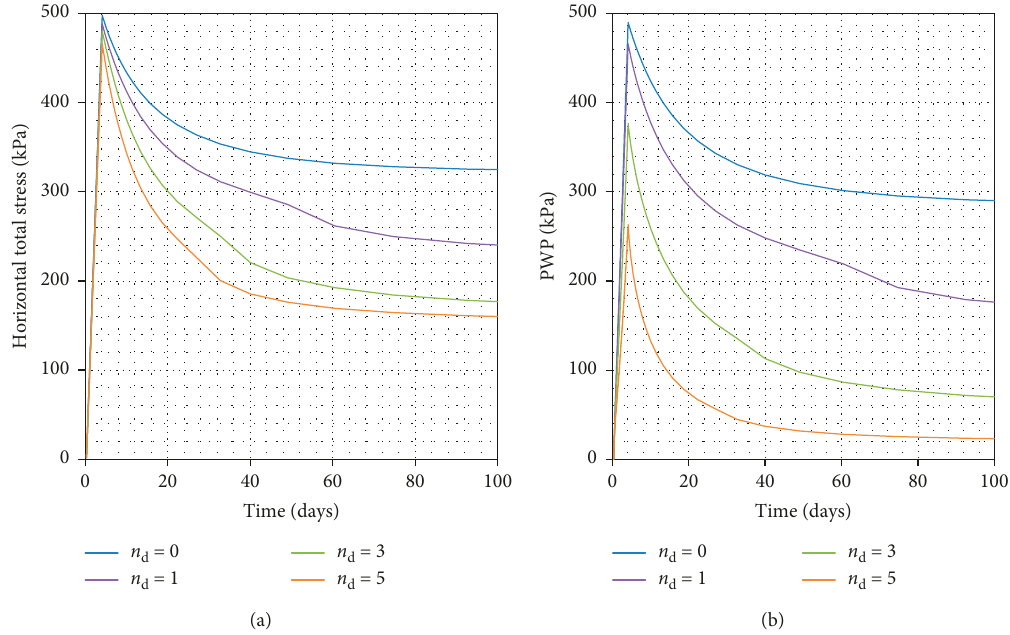
Figure 14: Evolution of the (a) horizontal total stress σ h and (b) PWP u w at midheight of the barricade for four different numbers of draining holes through the barricade (see the details in Table 1, Case